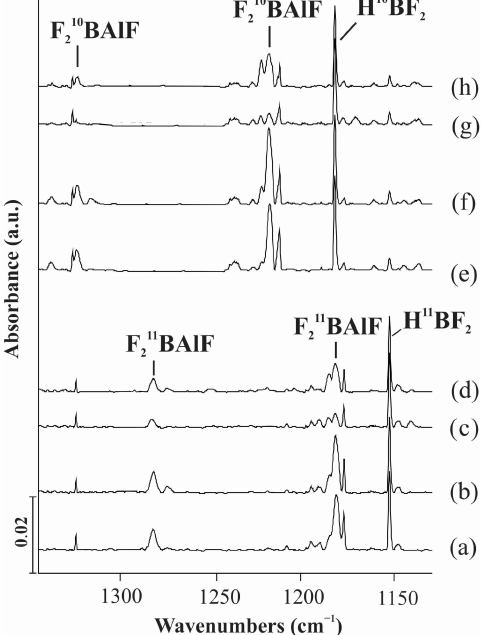
Figure 3. Infrared spectra of the laser-ablated Al atoms reactions with BF 3 in excess solid neon. ( a ) co-deposition of Al + 0.5% 11 BF 3 for 60 min; ( b ) after annealing to 8 K; ( c ) after λ = 450 nm irradiation for 6 min; ( d ) after annealing to 12 K; ( e ) co-deposition of Al + 0.5% 10 BF 3 for 60 min; ( f ) after annealing to 8 K; ( g ) after λ = 450 nm irradiation for 6 min; ( h ) after annealing to 12